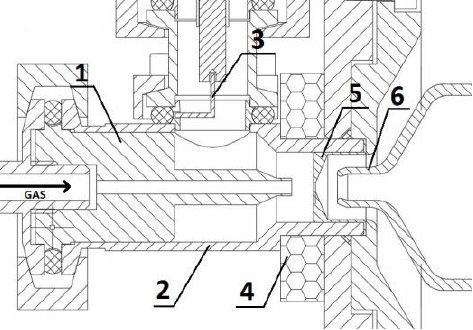
Fig. 1. Schematic view of ECR ion source based on a coaxial resonator: 1 - replaceable internal part of the resonator, 2 - external part of the resonator, 3 – coupling loop, 4 – permanent magnet ring, 5 - replaceable plasma electrode, 6 - pulling electrode.